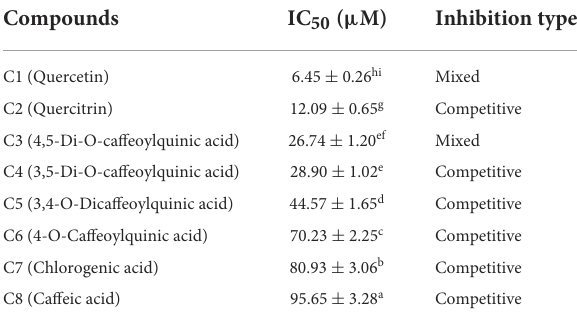
TABLE 1 Xanthine oxidase (XO) inhibitory activity of phenolic